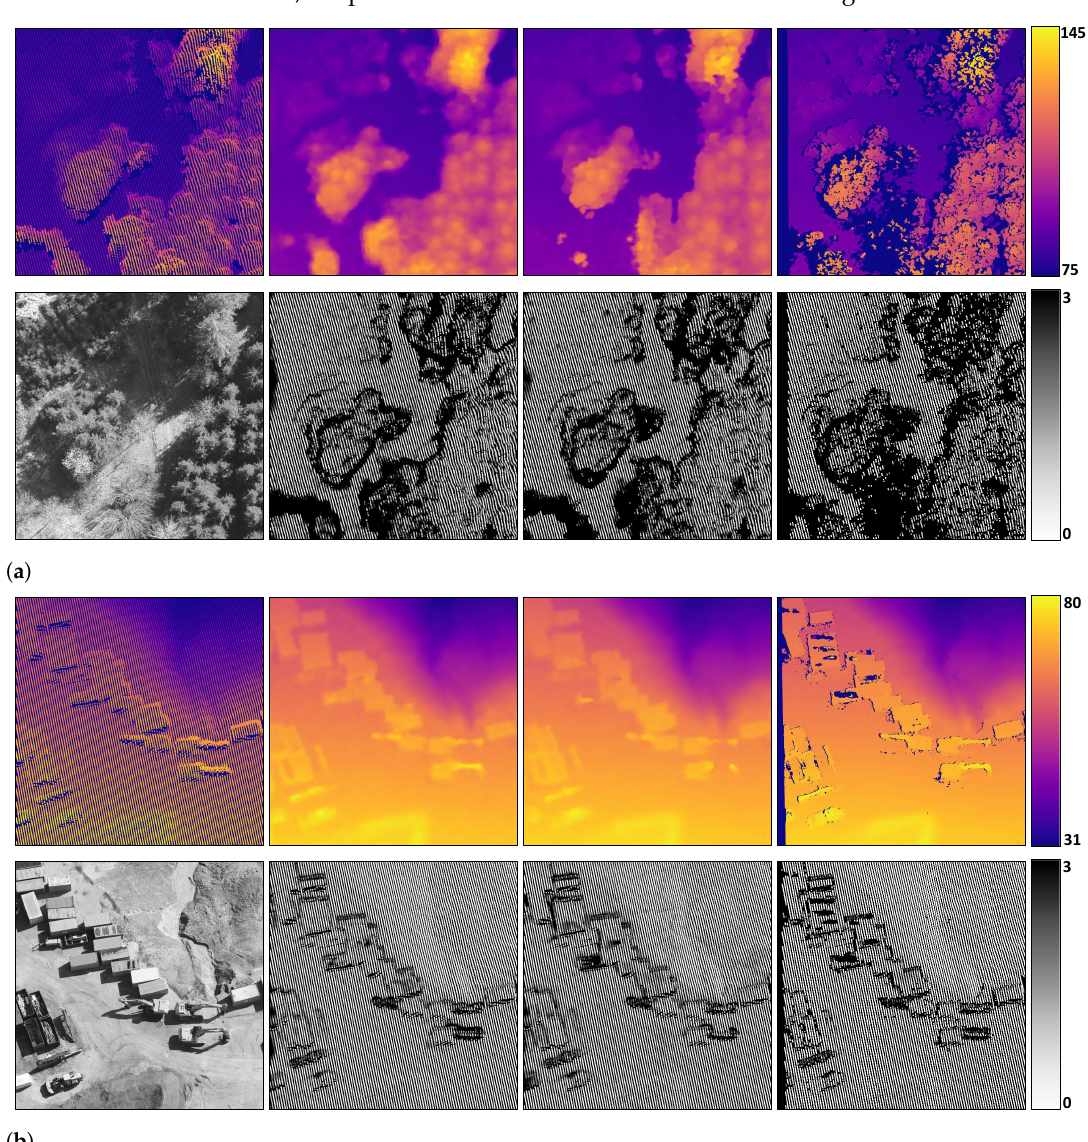
Figure 5. Visual comparison on aerial data. Two test cases regarding vegetation and building area are displayed in subfigure ( a , b ), respectively. In each subfigure, the reference disparity map and the stereo results from GA-Net-PyramidED, GA-Net and SGM are displayed from left to right in the first row. The second row provides the master epipolar image and the corresponding error map of each